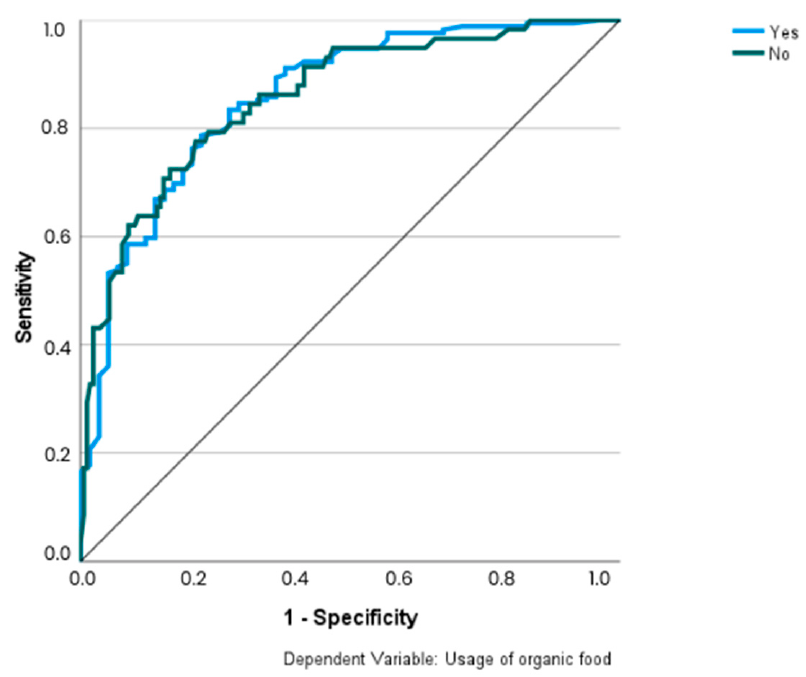
Figure 3. ROC curve for the ANN3 model; Source: Author’s work, using SPSS. Figure 4a,b are supporting sketches for assessing the performance of the classification model, presenting the gain and the lift of the ANN3 model. Gain is the proportion of all positive observations in the data to all positive observations up to a decile. The gain chart is a graph with the decile on the horizontal axis and the gain on the vertical axis. Lift is the proportion of positive observations up to the first decile that were observed using the model to positive observations up to that first decile that were anticipated to be observed using a random model. The relationship between the lift on the vertical axis and the matching decile on the horizontal axis is represented by a lift chart. Both charts confirm that the ANN3 model predicts the class of organic food users better than it does for